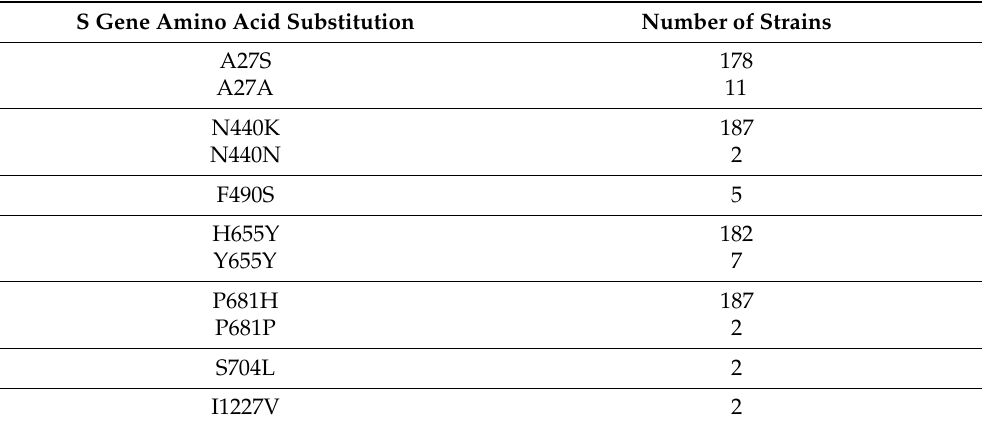
Table 3. Mutations registered in two or more BA.2 genomes from St. Petersburg. S Gene Amino Acid Substitution Number of